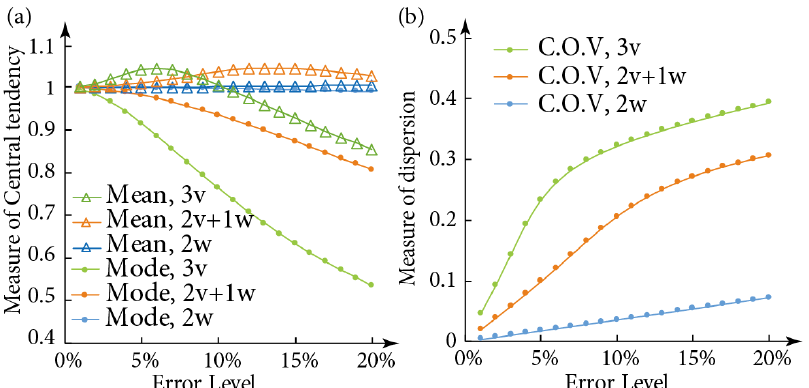
Figure 6. For the estimations of EI 2 using different sets ( 3v for ( v 5 , v 7 and v 9 ), 2v + 1w for ( v 5 , v 7 , w 9 ), 2w for ( w 5 and w 9 )) under error levels of 1~20%: ( a ) mean and mode, ( b ) coefficient of variation (c.o.v.).